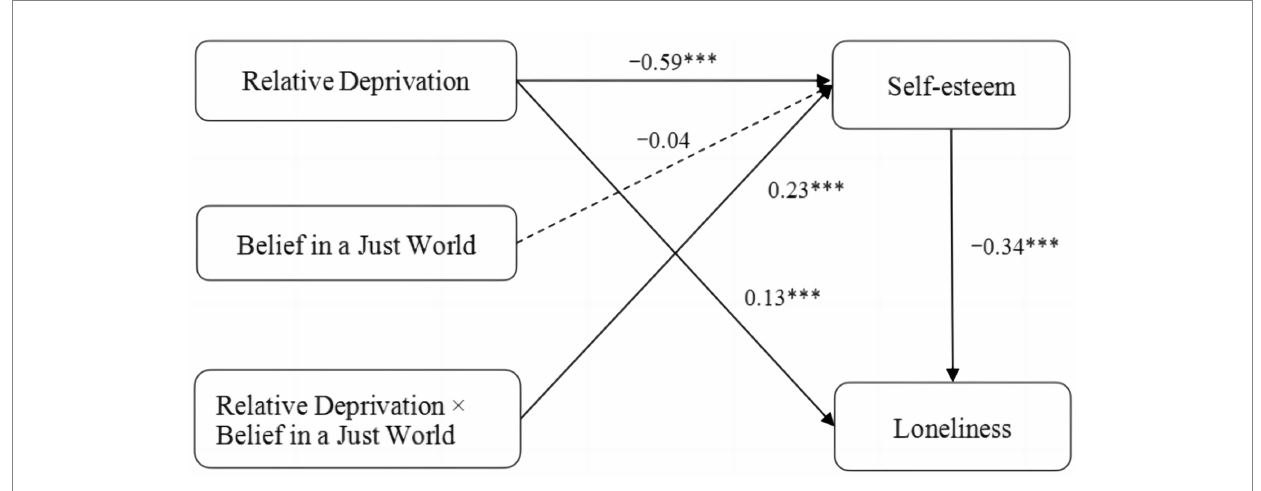
FIGURE 4 Moderated mediation model and key path coefficients for migrant children.